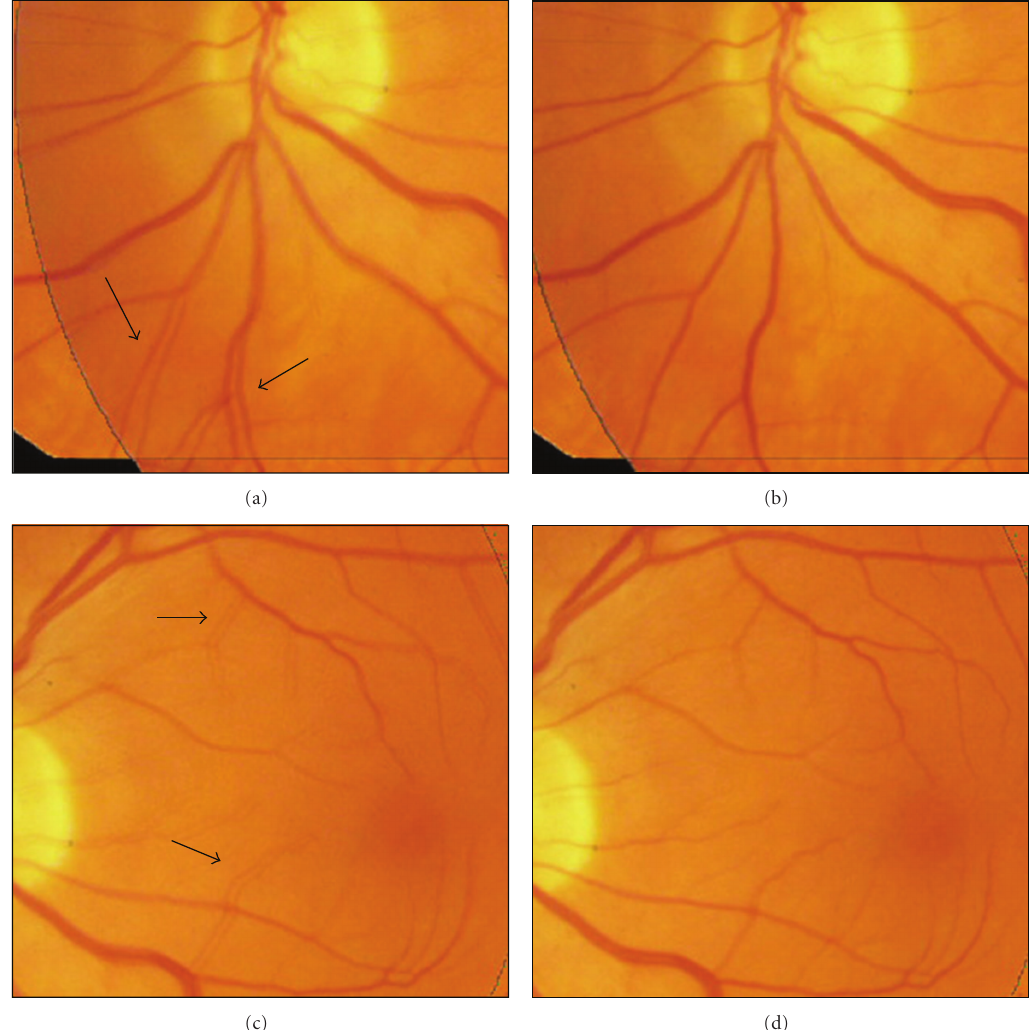
Figure 7: Fused retinal images. (a) and (b) with linear registration, some misalignment vessels were indicated with arrows; (c) and (d) with quadratic registration, vessels are well